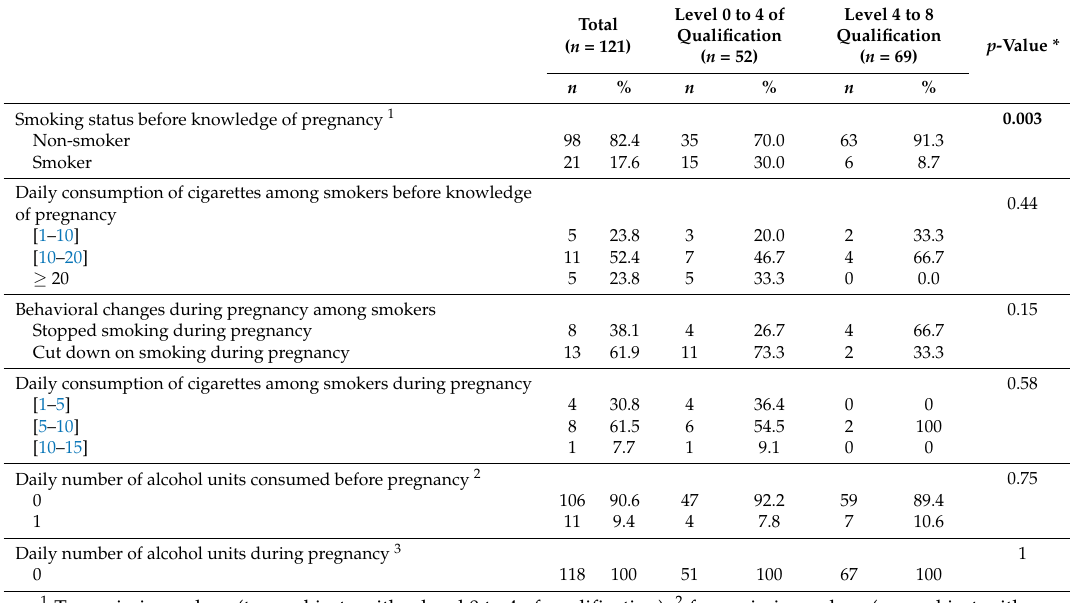
Table 5. Behavioral changes concerning alcohol and tobacco consumption during pregnancy ( n =